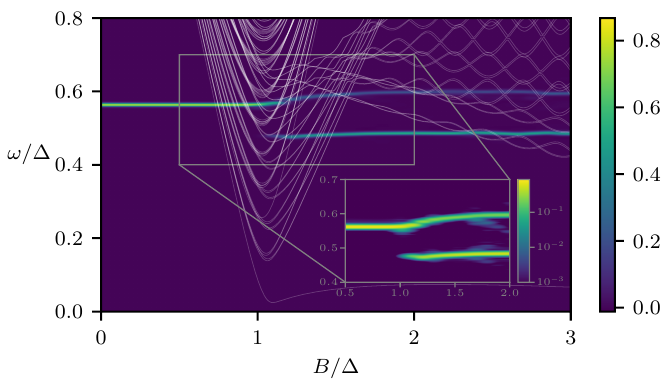
Figure 5: Spectral function obtained with DMRG and TEBD, for the weak-link model, = 0. Junction parameters in units of as a function of the Zeeman energy B for N g ∆ are E = 0.1, E 0 = 0.5, and wire tight-binding parameters are t = 1.5, v = 0.6, c J µ = 0, κ = 0.1. The length of each part of the wire is N = 40. White solid lines x are the energies of 2-quasiparticle excitations obtained from the BdG Hamiltonian for a phase difference of φ = 0 between the superconducting islands. Around the / ∆ = 1, as the bulk gap is closing, multiple 2-quasiparticle phase transition point B c states cross the plasma frequency. However, the effect of these states on the spectral function is very small. The inset shows a zoom-in on the region close to the phase transition, on a logarithmic color